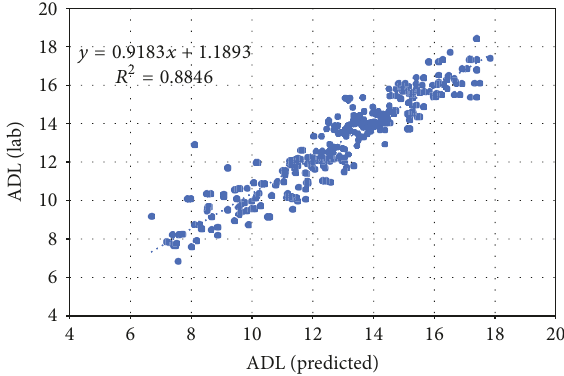
Figure 3: Linear regression relationship between laboratory refer- ence methods and NIRS-predicted values for ADL ( 𝑅 2 = 0.89 ) of winter and spring canola from 2011 on a dry weight